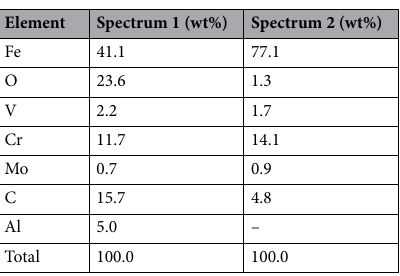
Figure 6. Surface profile map ( a ) and micrographs of worn surface morphologies ( b – f ), the cross-section of wear track ( d ) in BSE mode for EBM-processed high carbon martensitic stainless steel at 10 N and the optical microscopy of the worn surface of the alumina ball at 10 N ( g ).